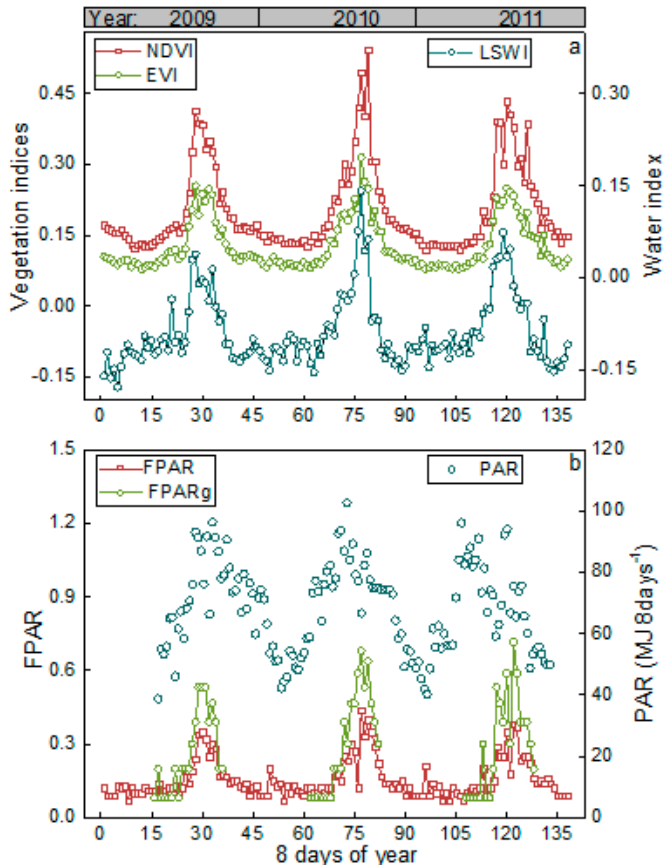
Figure 4. Seasonal variations of land surface vegetation and water indexes ( a ), and the photosynthetically active radiation (PAR) and the fraction of PAR absorbed by vegetation canopy (FPAR). ( b ) FPAR is directly obtained from MODIS products (MOD15A2H), while FPARg is calculated from ground measured leaf area index (LAI) based on the Beer–Lambert law.